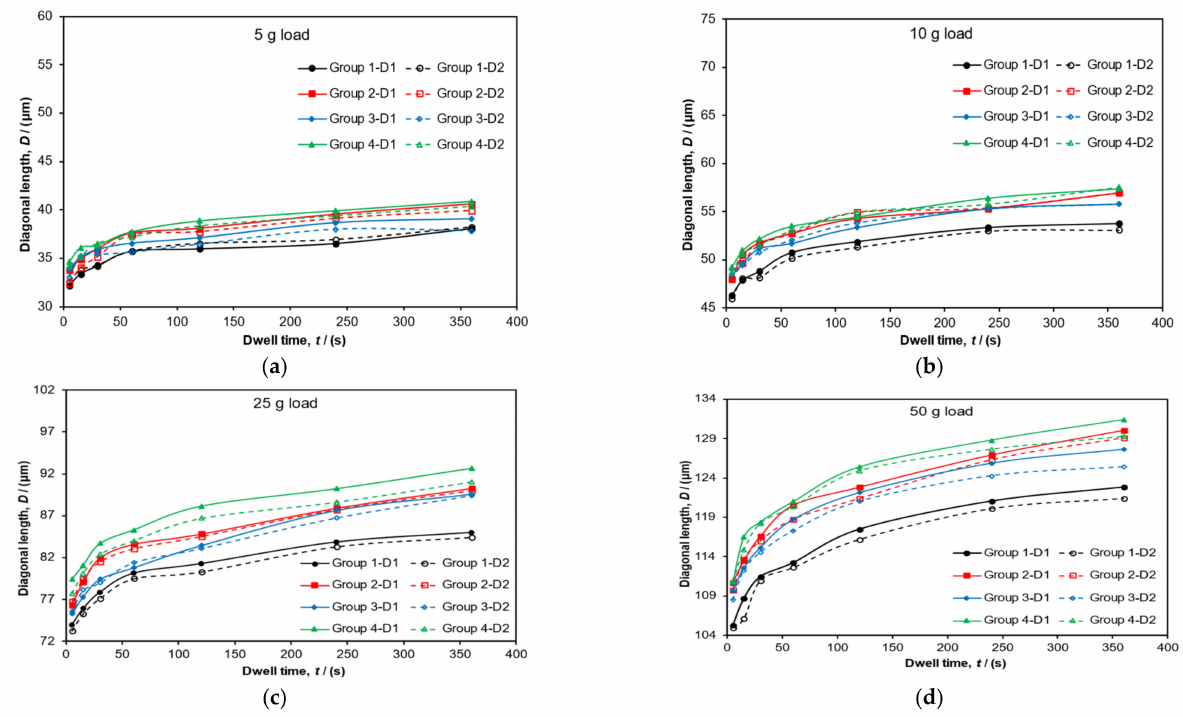
Figure 5. The relationship between diagonal lengths and dwell time at each load level. Trendlines connecting the data points are